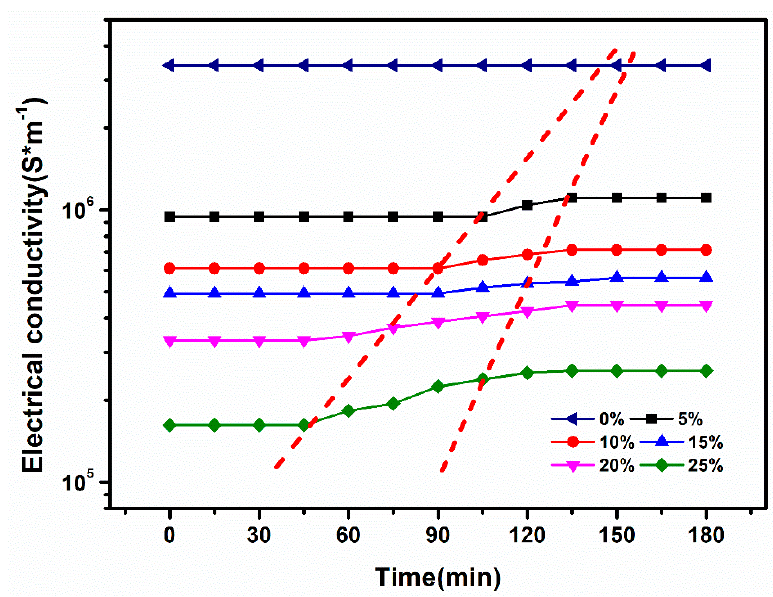
Figure 7. Variation of conductivity with time for different volume fractions of ϕ s